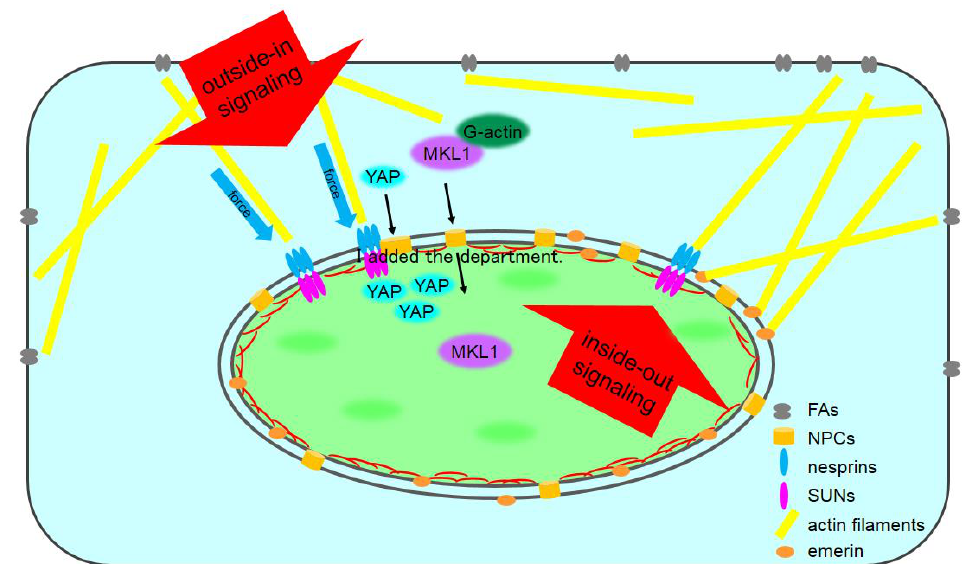
Figure 1. A model of Linker of Nucleoskeleton and Cytoskeleton (LINC) complex-mediated inside-out and outside-in signaling pathways. An enormous number of signaling pathways are integrated within cells. Outside-in signaling pathways, which originate within the cytoplasm or extracellular environment and terminate within the nucleus, can be roughly categorized into two groups. In the first pathway, mechanical stimuli are directly transferred to the nucleus via the LINC complex. The second pathway utilizes transcription factors such as Yes-associated protein (YAP) and megakaryoblastic leukemia 1 (MKL1) that shuttle between the cytoplasm and the nucleus through the nuclear pore complex (NPC). More importantly, the nucleus also plays a role as an information submission source. Inside-out signaling results in the transfer of signals from the nucleoplasm to the cytoplasm across the nuclear envelope (NE). SUN domain: Sad1/UNC-84.